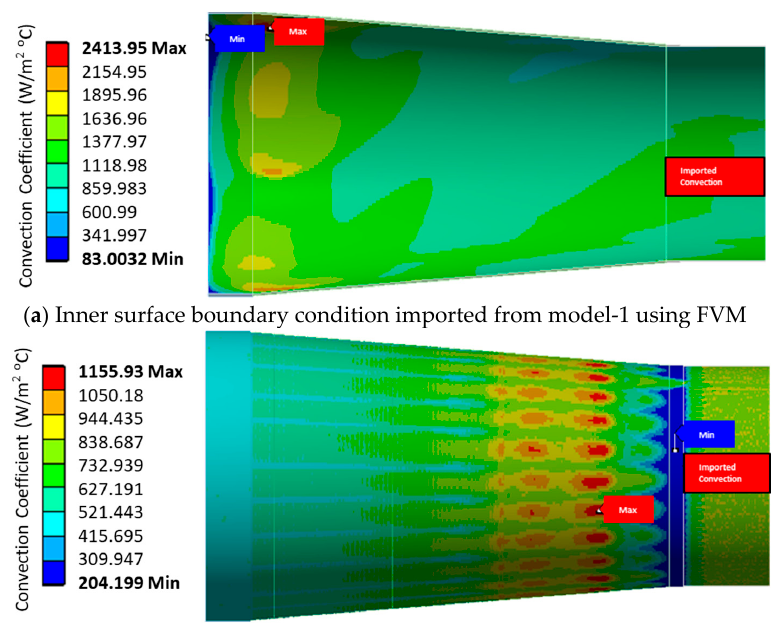
Figure 10. The imported heat transfer coefficient on the hot side and cooling side of the combustor liner for model-3.